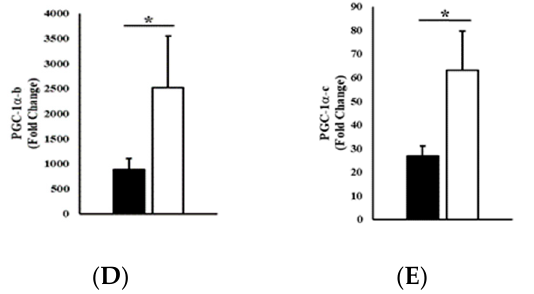
Figure 1. RT-qPCR analysis in response to exercise in cold (C, − 2 °C) and in room temperature (RT, 20 °C) conditions. Fold-change was calculated using the 2 −ΔΔ CT method [24] relative to stable reference genes and to the pre-intervention time-point. Thus, all pre-exercise values were normalized to 1.0. ( A ) Total PGC-1 α ; ( B ) Total NT-PGC-1 α ; ( C ) PGC-1 α -a ; ( D ) PGC-1 α -b ; ( E ) PGC-1 α -c . Data are expressed as means ± SE ( n = 9). * p < 0.05 from pre-exercise. † p < 0.05 from RT trial.